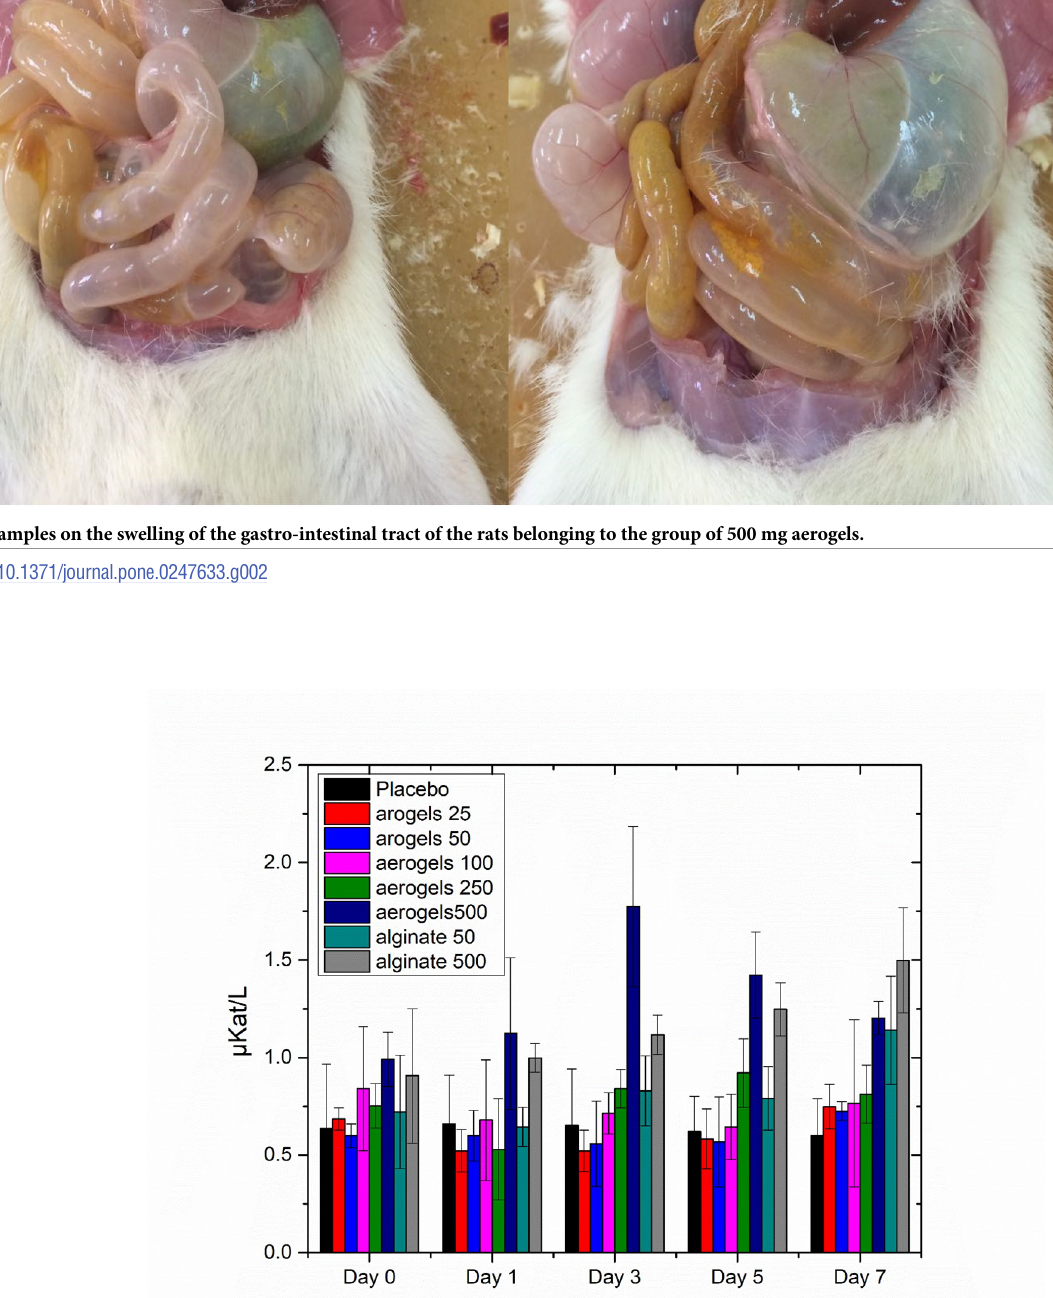
PLOS ONE | https://doi.org/10.1371/journal.pone.0247633 April 28,